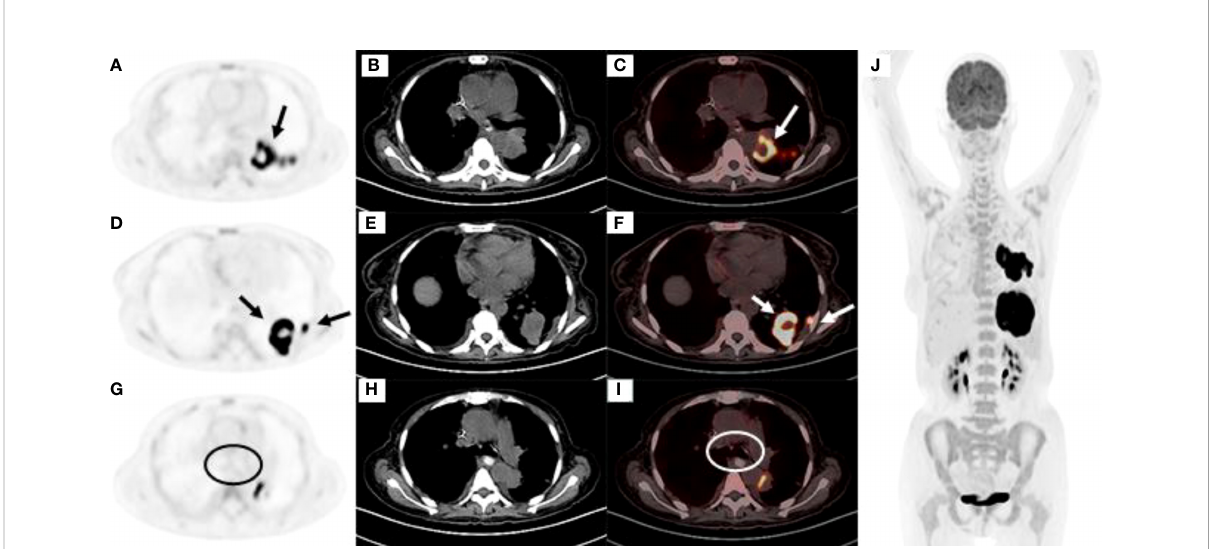
FIGURE 3 (A ‒ C) High FDG uptake at the dorsal segment of the left lower lobe (A) PET image, (B) CT mediastinal window, (C) PET and CT fusion images. (D ‒ F) High FDG uptake at the posterior basal segment and lateral basal segments of the left lower lobe (D) PET image, (E) CT mediastinal window, (F) PET and CT fusion images. (G ‒ I) No FDG uptake was observed in the mediastinal lymph nodes as shown within the circle (G) PET image, (H) CT mediastinal window, (I) PET and CT fusion images. (J) Except for the left lung tumor, there was no obviously high metabolism in other parts of the